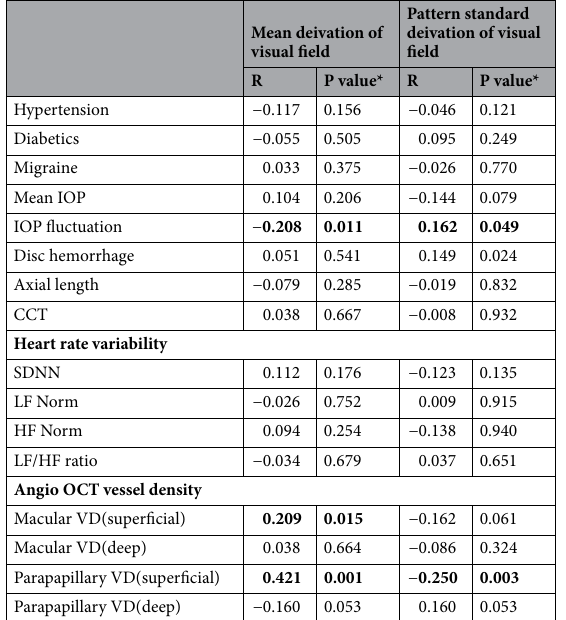
Table 2. Correlation coefficients for mean deviation, pattern standard deivation of visual field with ocular parameters and heart rate variability in total subjects. IOP = intraocular pressure; SDNN = Standard deviation of NN-interval; LF = Low frequency ; HF = High frequency ; OCT = Optical coherence tomography; VD = Vessel density. R = correlation coeffcient. *Pearson correlation analysis.